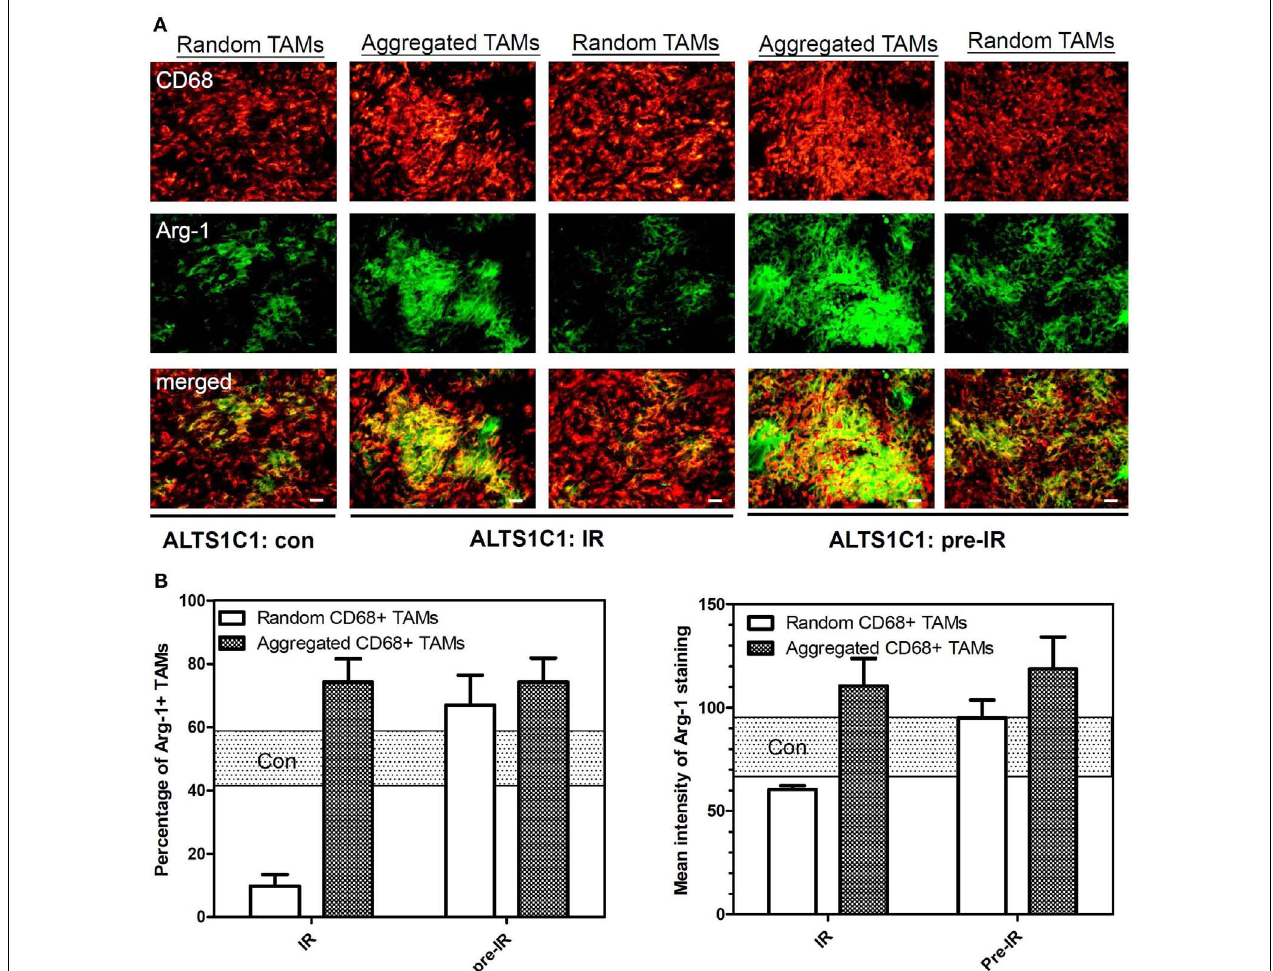
percentage of Arg-1 + TAMs (left graph) and the mean intensity of Arg-1 staining (right graph) by random or aggregated CD68 + TAMs in control (rectangular dot region), irradiated (IR) (white bar) or pre-irradiated (pre-IR) (dark dot bar) ALTS1C1 tumors.The rectangular dot region represents the average value ± SD in control ALTS1C1 tumor for the purpose of